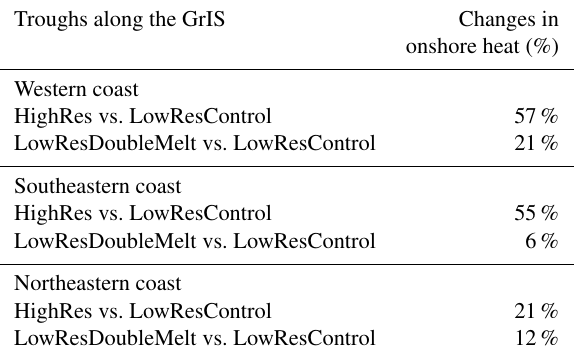
Table 4. This table shows the percentage of the difference be- tween the onshore sum of yearly heat fluxes from three experiments, HighRes, LowResControl, and LowResDoubleMelt, from 2004 to 2016. The western coast includes the Melville Bay central trough (MVBCT) and Disko Bay trough (DBT), the southeastern coast sec- tor includes Helheim Glacier trough 2 (HGT2) and Kangerlussuaq trough (KT), and the northeastern coast includes Scoresby Sund trough (SBST) and Norske trough (NT). These troughs can be iden- tified in Fig.